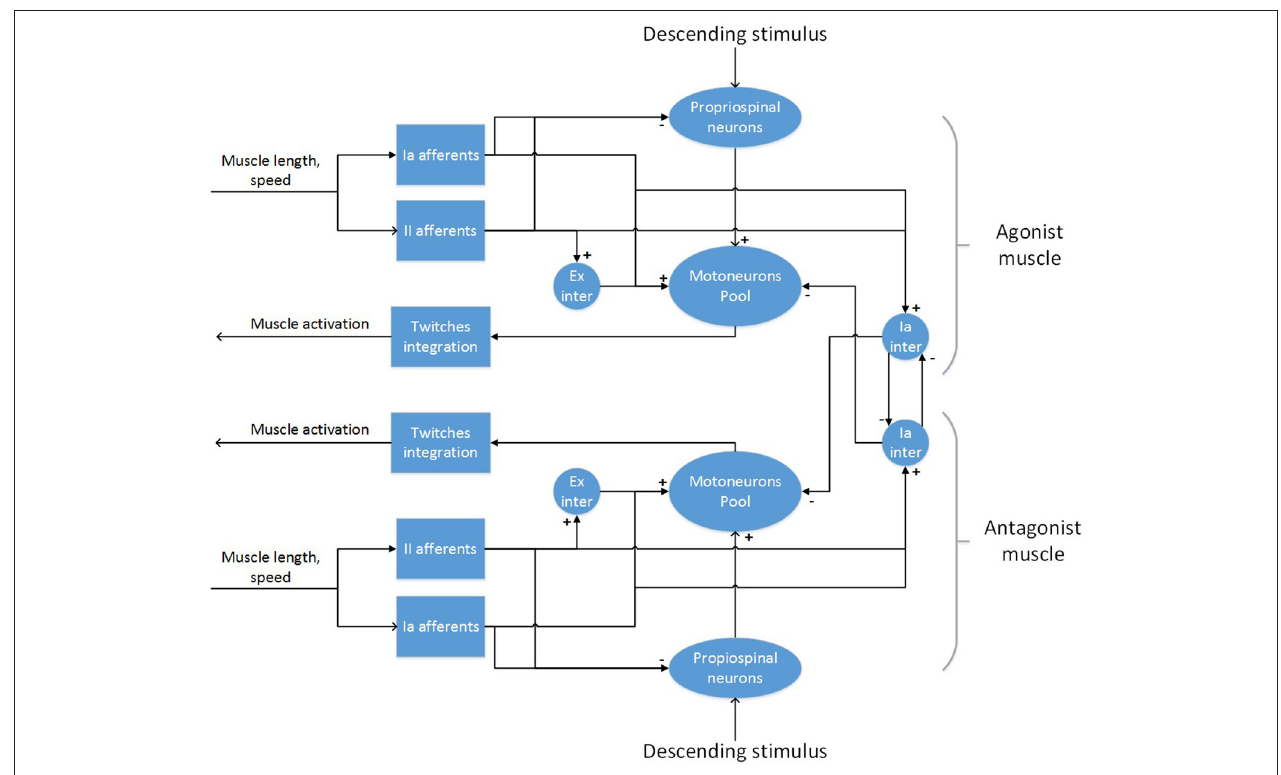
FIGURE 4 | The spinal cord model for a pair of antagonistic muscles.